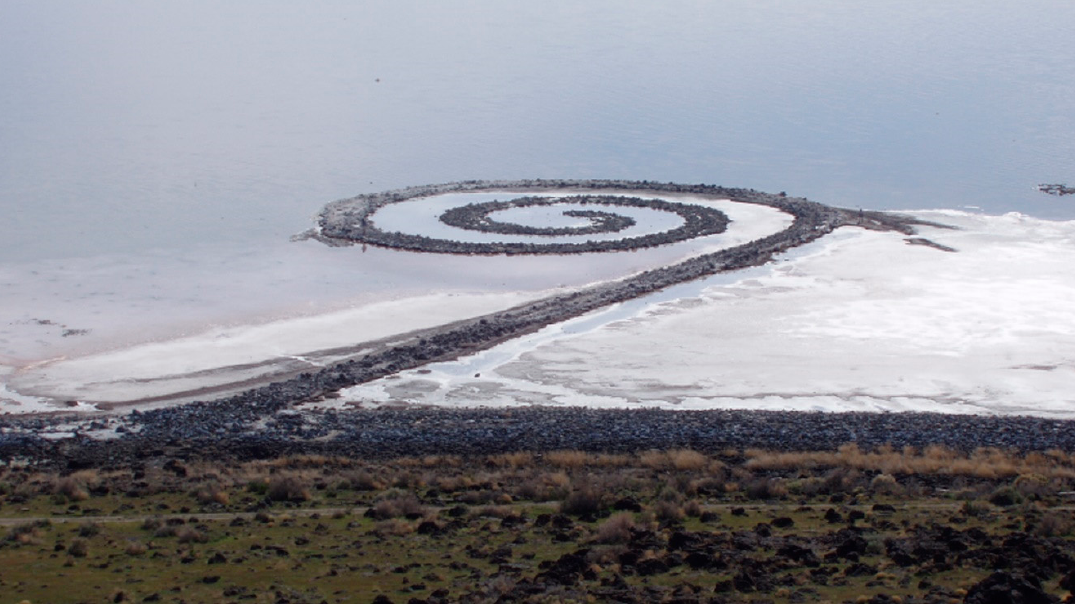
Figure 7. Robert Smithson—Spiral jetty (1970).